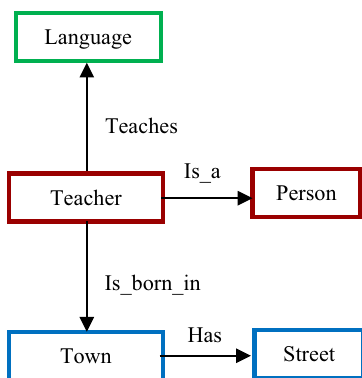
Fig. 4 Graph conceptual schema